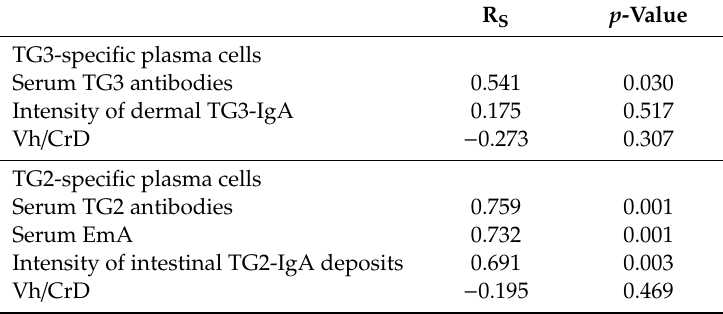
Table 3. Correlations between the percentages of intestinal transglutaminase (TG) 3- and 2-specific plasma cells and relevant serum, skin, and small bowel mucosal findings in dermatitis herpetiformis (DH) patients at post-challenge. R S , Spearman correlation coe ffi cient. A p -value < 0.05 was considered significant. R S p -Value TG3-specific plasma cells Serum TG3 antibodies 0.541 0.030 Intensity of dermal TG3-IgA